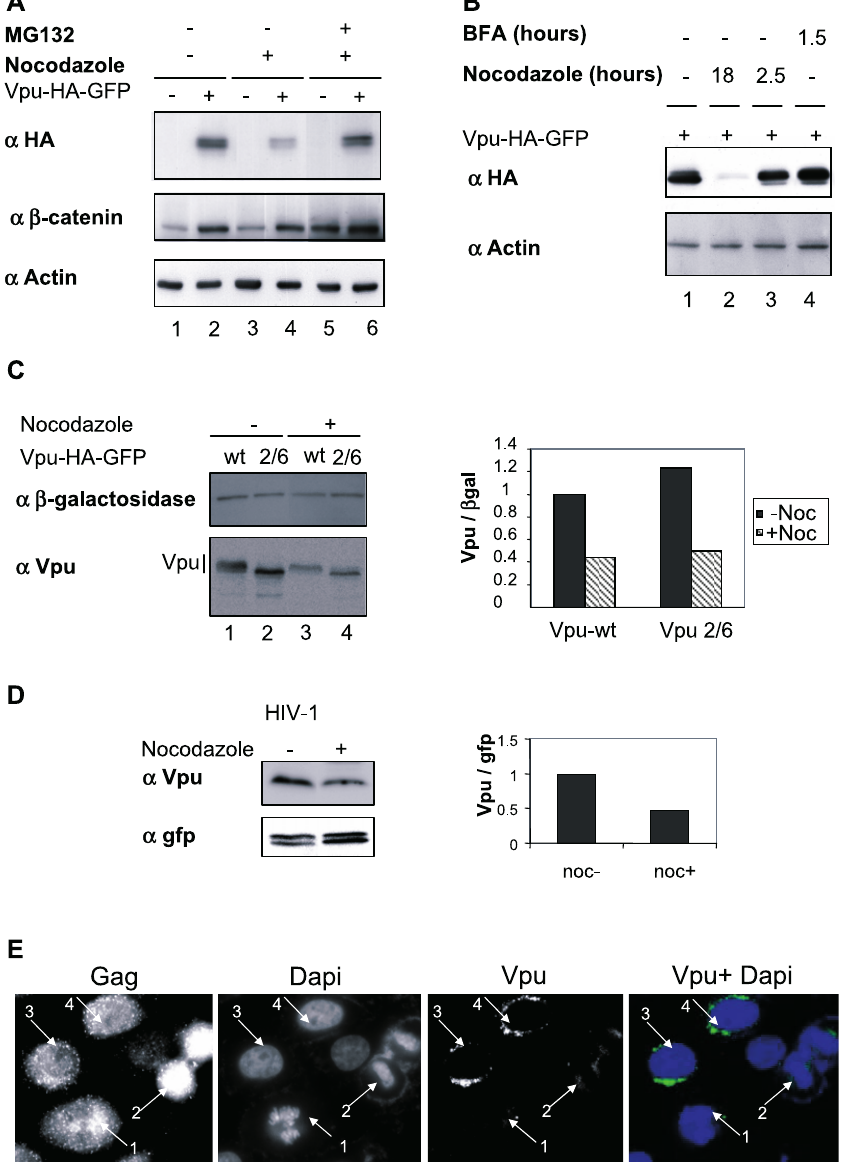
Figure 2. Vpu Degradation in Nocodazole-Treated Cells Is Independent of the SCF b TrCP Activity (A) Vpu degradation occurs via the proteasome pathway. HeLa cells either mock-transfected (lanes 1, 3, and 5) or expressing Vpu-HA-GFP (lanes 2, 4, and 6) were left untreated or treated for 18 h with nocodazole (lanes 3–6). Where indicated, MG132 was added 6 h prior to harvest of cells. Cell lysates were analyzed by western blot using the indicated antibodies. (B) Vpu expression is not sensitive to brefeldin A or to short nocodazole treatments. HeLa cells expressing Vpu-HA-GFP were treated with nocodazole during either 18 h (lane 2) or 2.5 h (lane 3) and with BFA during 1.5 h (lane 4) or DMSO alone (lane 1). Cell lysates were separated by SDS-PAGE and analyzed by western blot using the indicated antibodies. (C) Degradadion of Vpu in nocodazole-treated cells does not require a functional b TrCP-binding site. HeLa cells were transfected with the expression vectors encoding either wild-type Vpu-HA-GFP (lanes 1 and 3) or the Vpu 2/6-HA-GFP mutant defective in b TrCP binding (lanes 2 and 4), together with a plasmid expressing Myc- b galactosidase used as an internal reporter. Cells were left untreated or treated 18 h with nocodazole as indicated. Vpu-HA-GFP and Myc- b galactosidase were revealed by western blot using anti-Vpu and anti-myc antibodies, respectively. The histogram represents the Vpu/ b galactosidase ratios, calculated from the respective quantified signals. (D) Vpu expression from the HIV-1 provirus is reduced in nocodazole-treated cells. HeLa cells were transfected with pNL4–3 D Vpr provirus together with a plasmid expressing GFP used as an internal control. Cells were treated with nocodazole where indicated. Vpu was detected by western blot using anti- Vpu antibodies. (E) Vpu is not detectable in infected mitotic cells. HeLa cells were transfected by the pNL4–3 provirus. 48 h after transfection, cells were fixed and analyzed by immunofluorescence using anti-Gag and anti-Vpu antibodies. DNA was revealed by DAPI staining. Arrows 1 and 2 indicate mitotic cells and arrows 3 and 4 indicate interphasic cells. wt, wild-type.